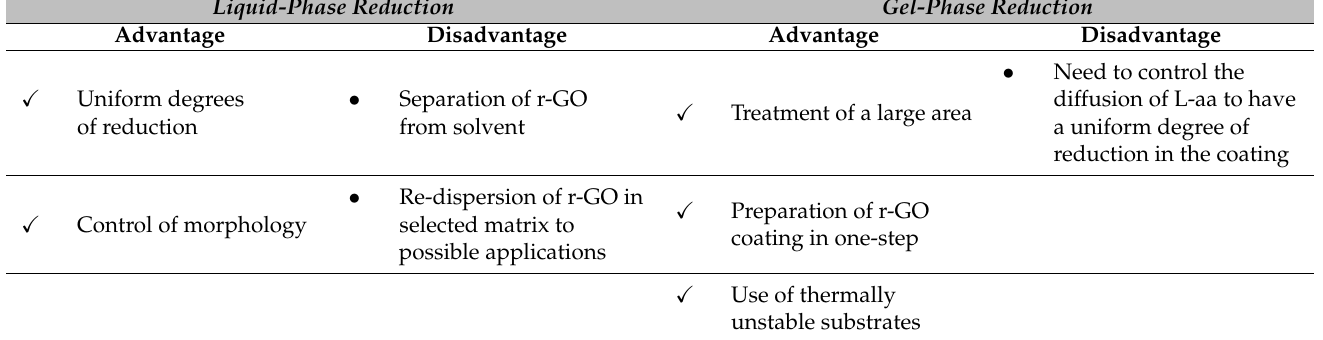
Table 4. Summary of principal advantages and disadvantages of liquid-phase and gel-phase approaches.